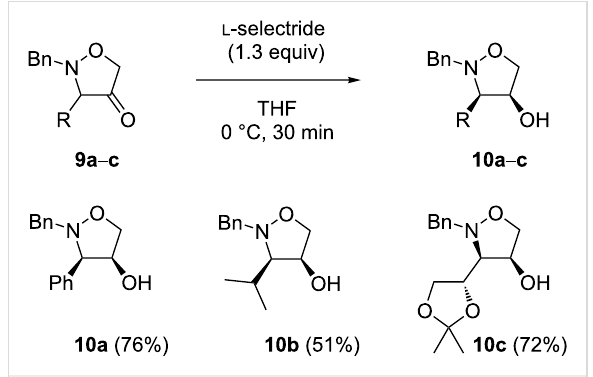
Scheme 4: Inversion of the relative configuration of the isoxazolidine ring.